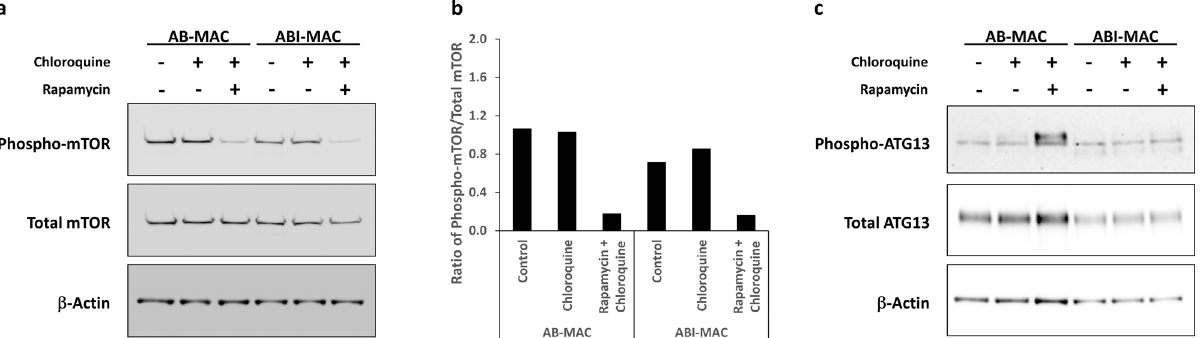
Figure 3. Induction of autophagy by IL-27 is independent of mTOR activity. AB-MAC and ABI-MAC were seeded in 6-well plates (1.5 × 10 6 cells /well) and incubated overnight in complete medium with or without either chloroquine or a combination of chloroquine and rapamycin as described in the Materials and Methods. ( a ) Total cell lysates were separated on a 3–8% Tris–Acetate gel and transferred onto a 0.45 μm